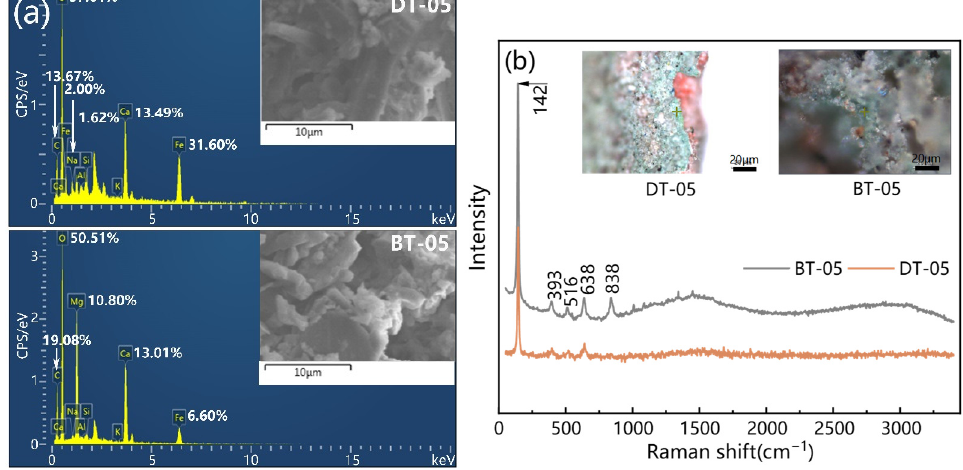
Figure 8. ( a ) Elemental analysis by SEM-EDS and ( b ) Raman spectra for the green samples (DT-05 and BT-05).